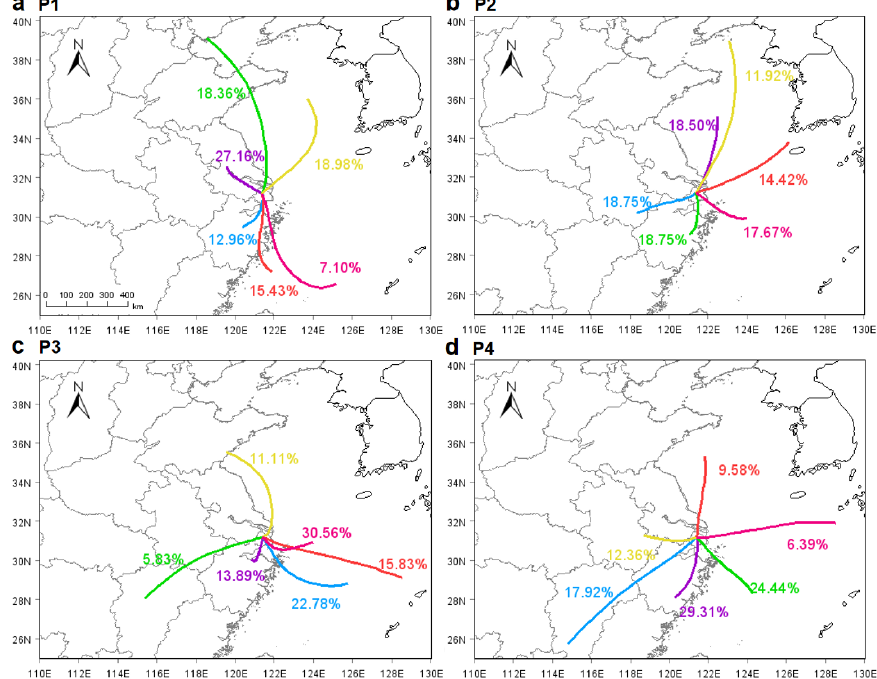
Figure 5. The air mass transport from P1 to P4 in 2022 ( a - d ) in Shanghai region by cluster analysis of backward trajectories. backward